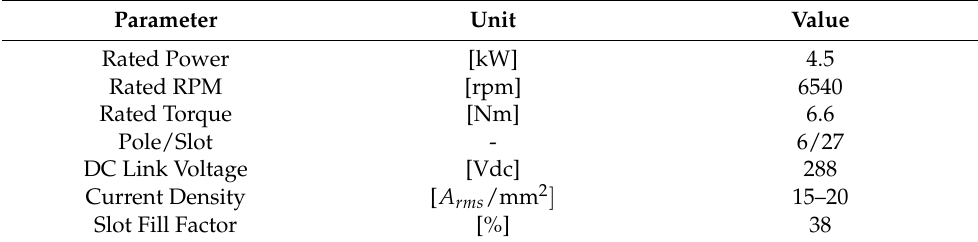
Table 1. Design specification of SPMSM for EV air conditioner